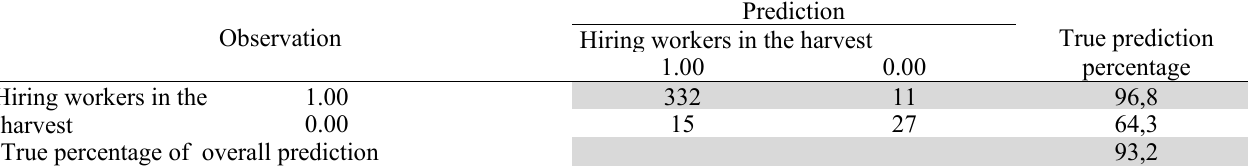
Forecasting logistic model results for migration characteristics impact on hiring workers in the harvest Observation